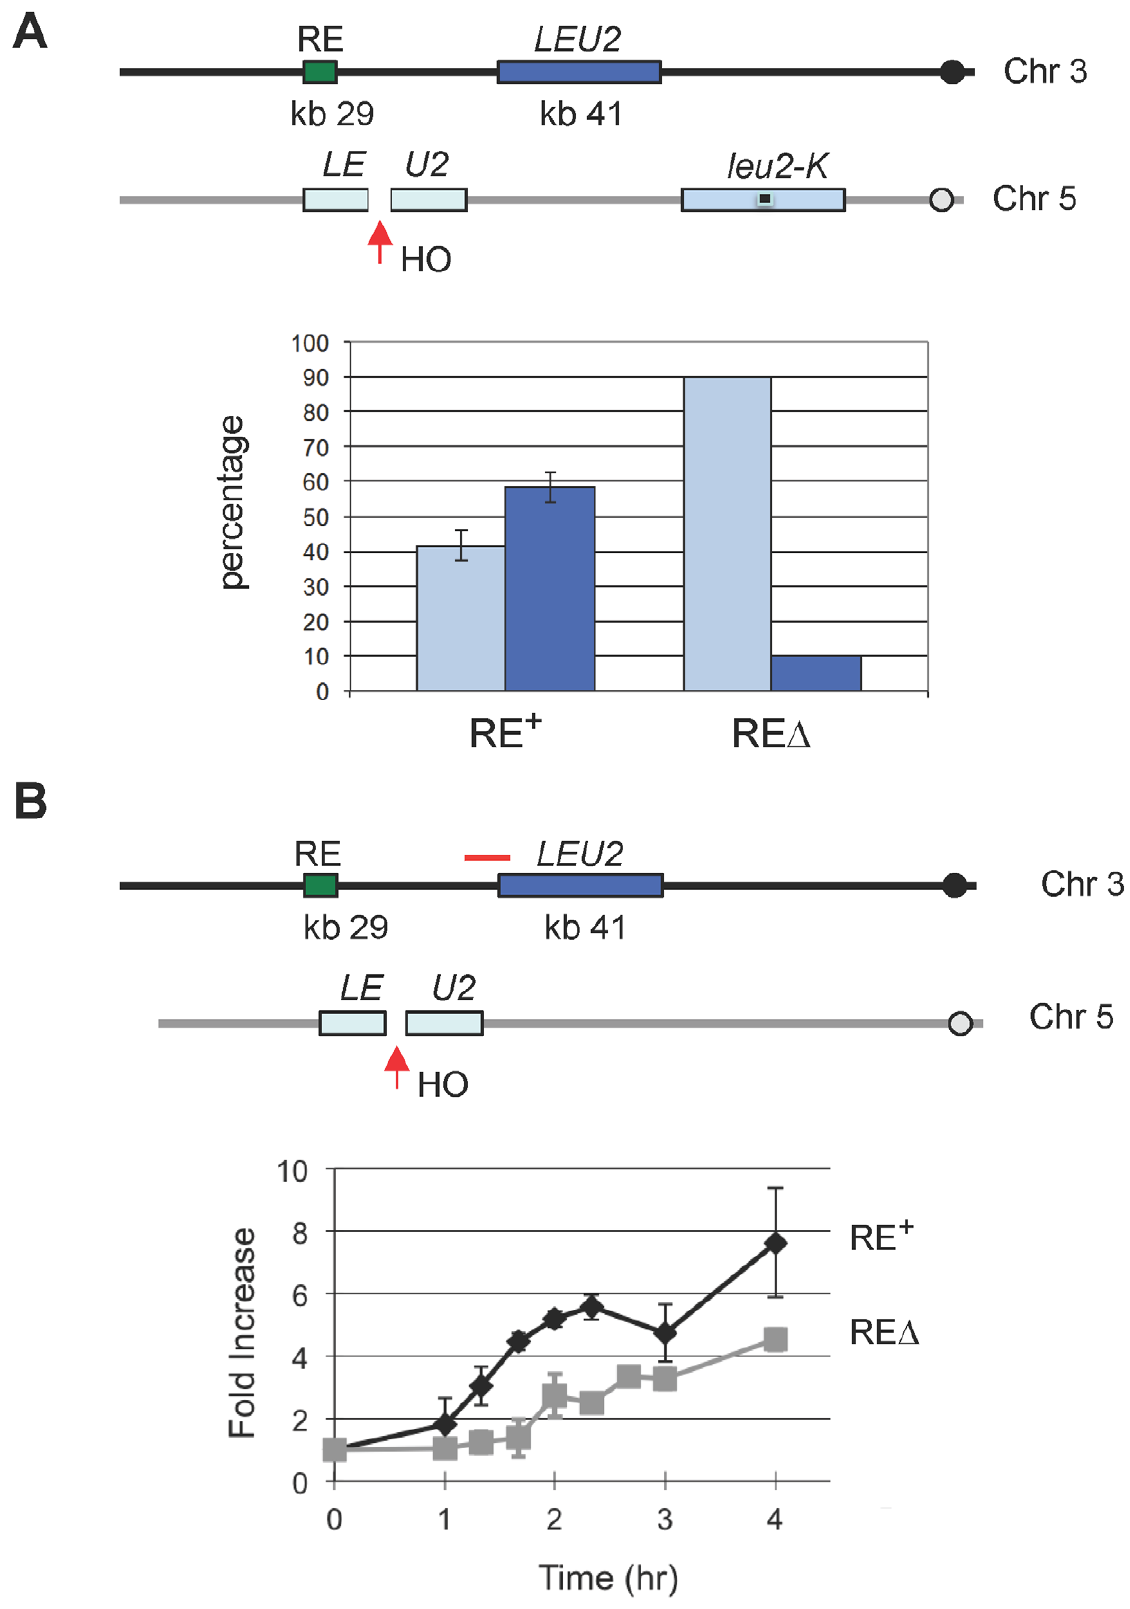
Figure 5. The Presence of RE Promotes DSB–Mediated Interchromosomal Gene Conversion and Accelerates Rad51 Synapse Formation. (A) The presence of RE promotes the usage of its adjacent inter-chromosomal donor for DSB repair. An HO cut site was previously introduced to the Kpn I site of the LEU2 to generate leu2::HOcs [54]. YCSL001 (as depicted) contains the leu2::HOcs at the can1 locus on chromosome V. PLoS Genetics |